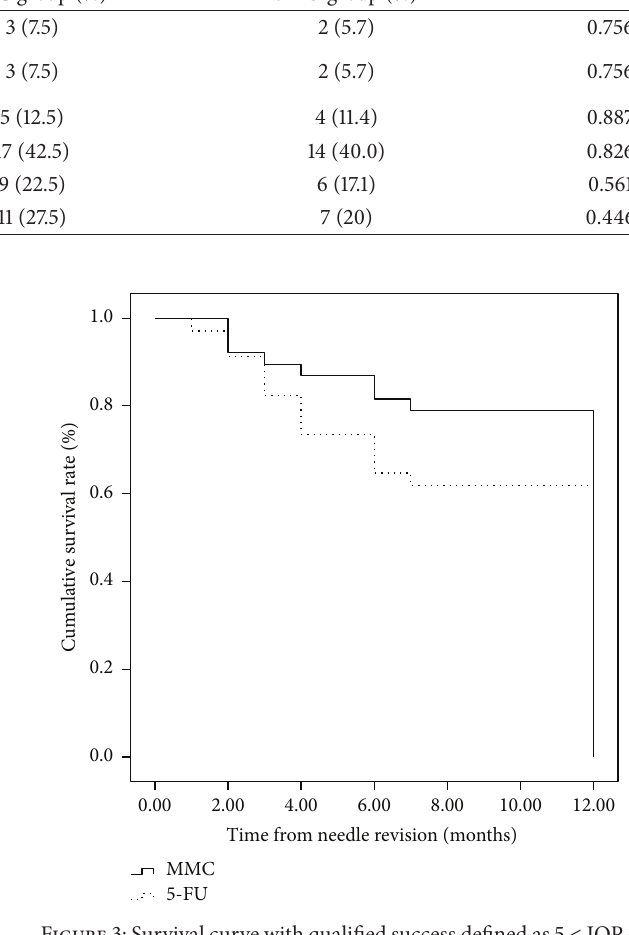
Figure 3: Survival curve with qualified success defined as 5 < IOP < 21 mmHg with and without glaucoma medication ( 𝑃 = 0.145